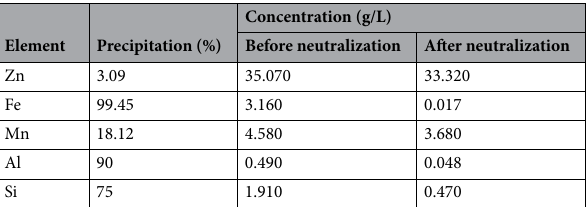
Table 6. Zn, Mn, and Fe concentration before and after the neutralization stage.